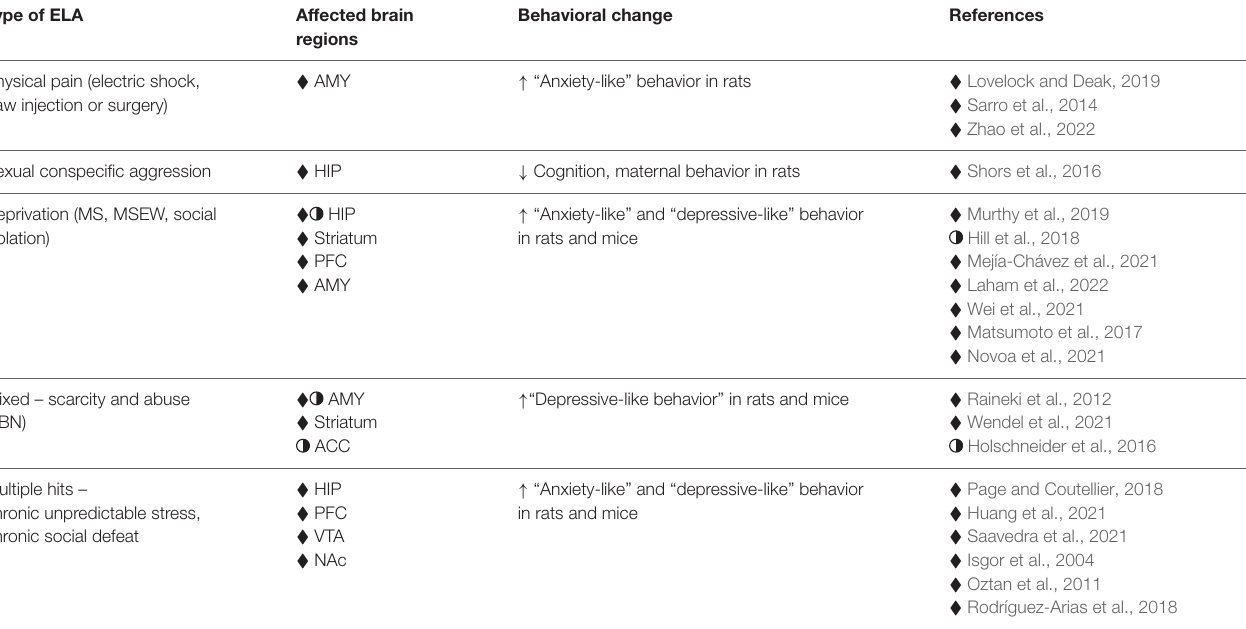
TABLE 2 | Brain changes and behaviors resulting from different types of ELA in